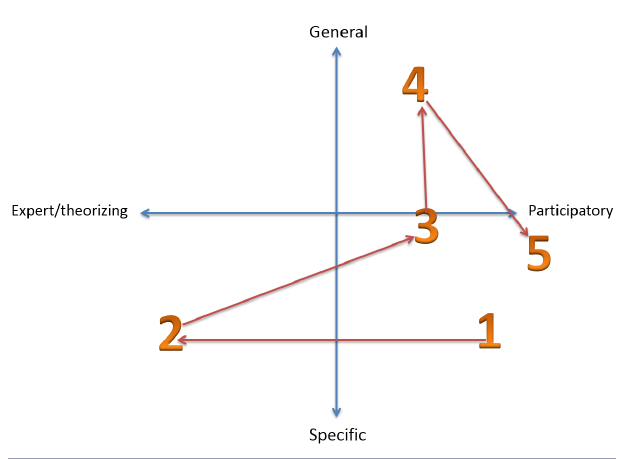
Fig. 7 . Loring’s research